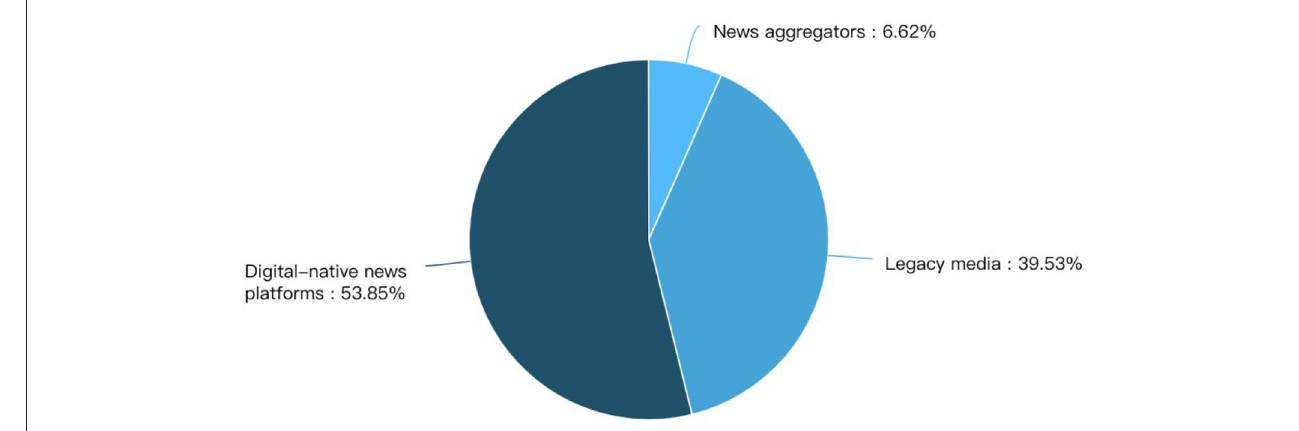
FIGURE3 Different media type that cover preprints.